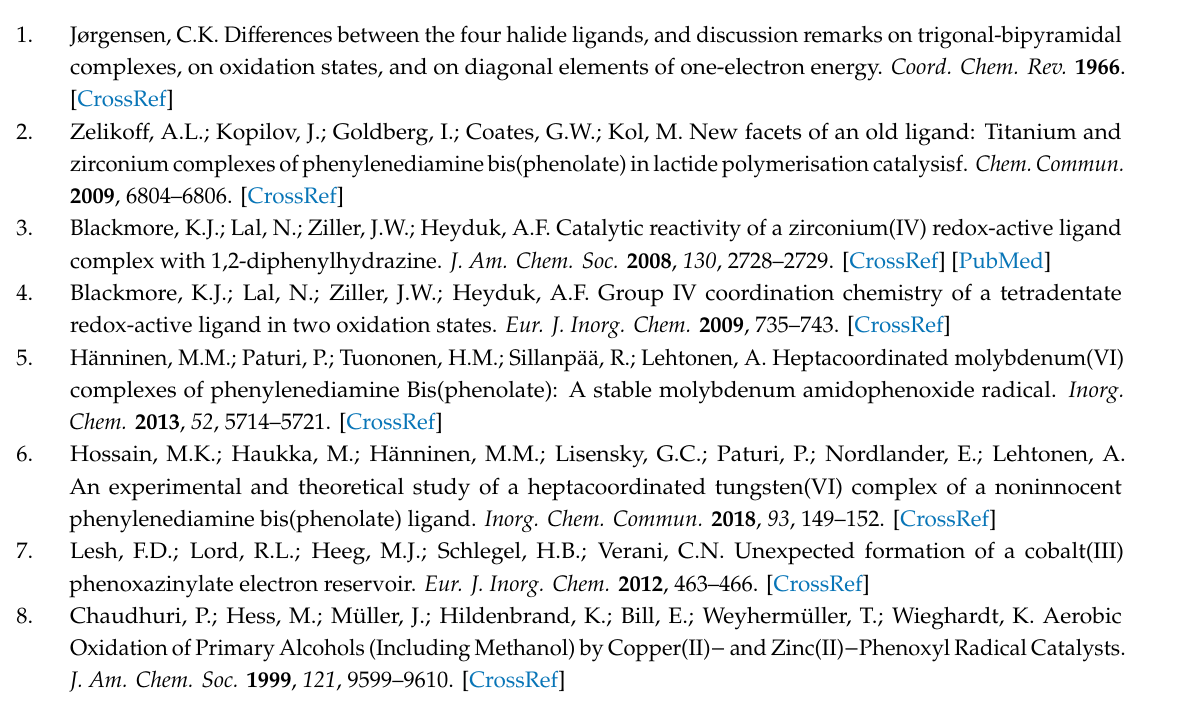
NMR spectra. Figures S29–S30: Evans’ method NMR measurements. Table S2: Experimental and optimized (DFT) bond parameters. Table S3 Optimized Cartesian